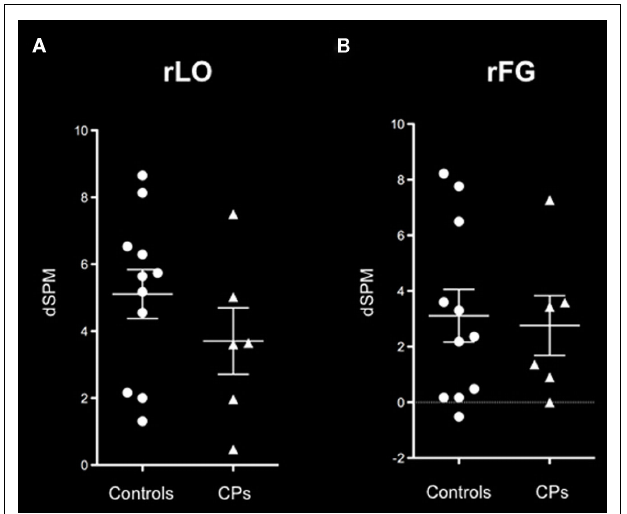
FIGURE 4 | M170 “face-selectivity” effects within (A) rLO and (B) rFG show no difference between healthy controls (circles) and individuals with CP (triangles). On each graph the mean and the SEM are represented.